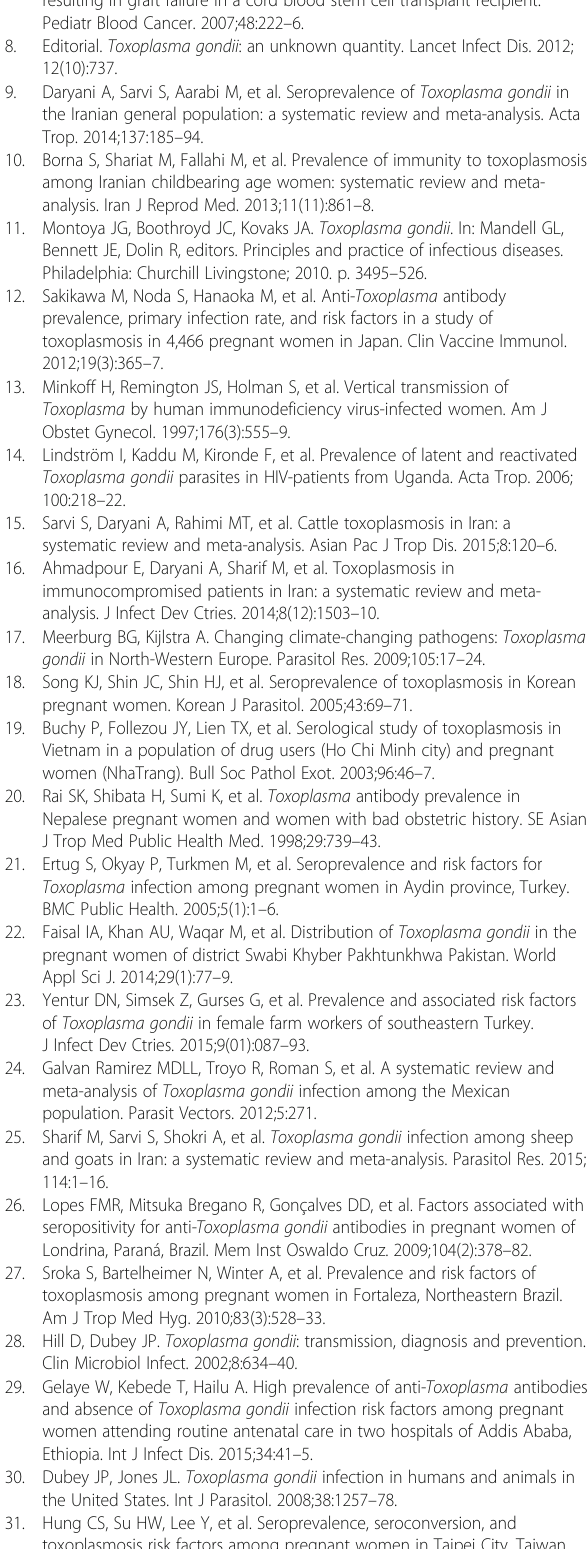
Additional file 4: Table S3. Girls and women of childbearing age group methods of included data. (DOCX 16 kb) Additional file 5: Table S4. Pregnant women group methods of included data. (DOCX 16